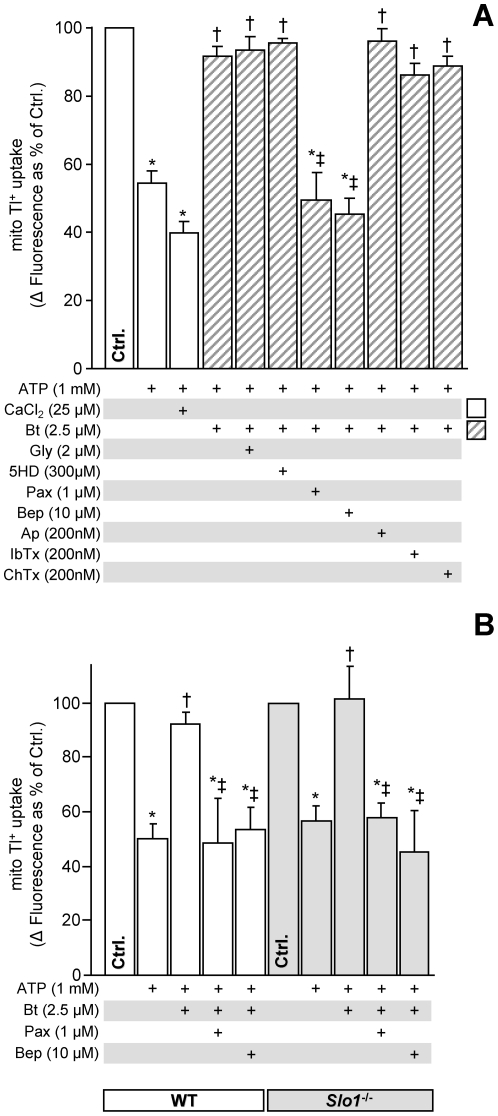
Mouse heart mBK channel activity is independent of Slo1.
(A) Pharmacologic characterization of mBK activity in isolated WT (C57BL/6) mouse heart mitochondria, measured using the Tl+-flux assay. Mitochondrial thallium (Tl+) uptake, a surrogate for K+ flux, was measured using a mitochondrial matrix loaded Tl+-sensitive fluorophore, as detailed in the methods section of Supporting Information S1. ATP was added to block the normally open mitochondrial mKATP channel [38], [20], [16]. Graph shows Δ fluorescence upon Tl+ addition to media. Where indicated, the BK channel activators Ca2+ (open bars) or bithionol (Bt, hatched bars) were added at the concentrations indicated. Optimal doses are shown, since higher concentrations compromised mitochondrial function (data not shown). The mKATP inhbitors glyburide (Gly) and 5-hydroxydecanoate (5-HD), and the K+ channel inhibitors paxilline (Pax), bepridil (Bep), apamin (Ap), charybdotoxin (ChTx) and iberiotoxin (Ibtx) were present as listed below the x-axis. (B) mBK channel activity in heart mitochondria isolated from Slo1-/- and WT FVB littermate mice. The baseline Δ fluorescence (Ctrl, set to 100%) was 21±4 and 22±4 arbitrary units in WT (white bars) and Slo1-/- (gray bars) respectively. Pharmacologic agents were present as listed below the x-axis. Data are means ± SEM, N>3 (N = independent mitochondria preparations). *p<0.05 vs. ctrl, †p<0.05 vs. ATP, ‡p<0.05 vs. ATP+Bt.